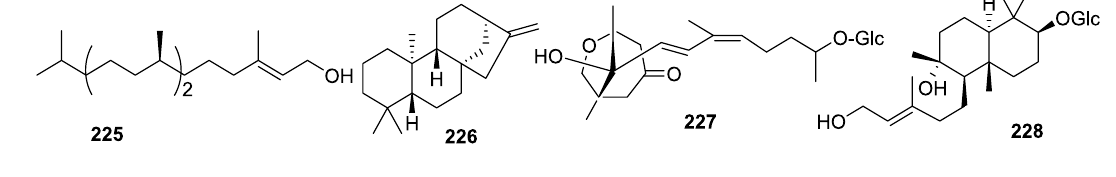
Fig. 5 Diterpenes 225 – 228 from Solanum